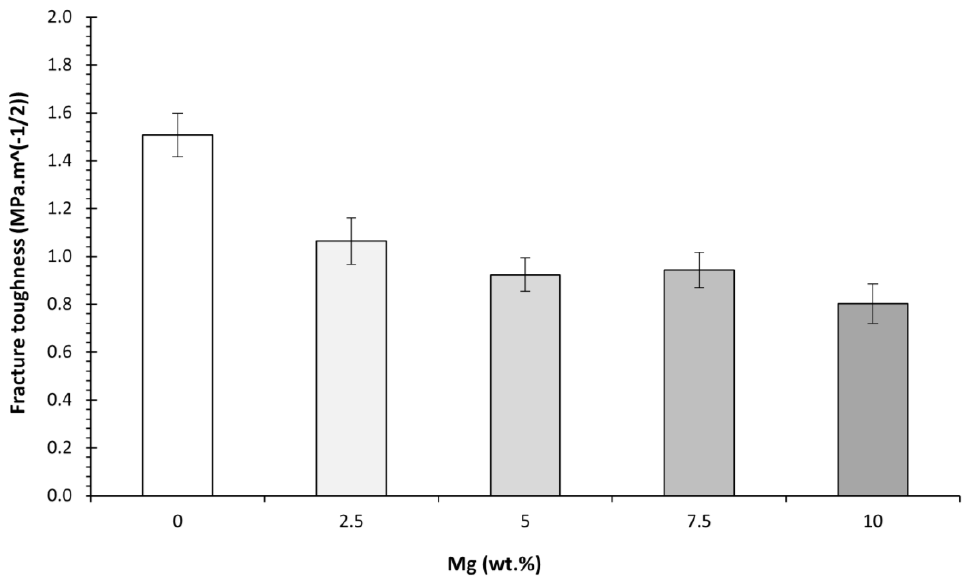
Figure 14. Evolution of the fracture toughness of PLA-Mg composites with Mg content.